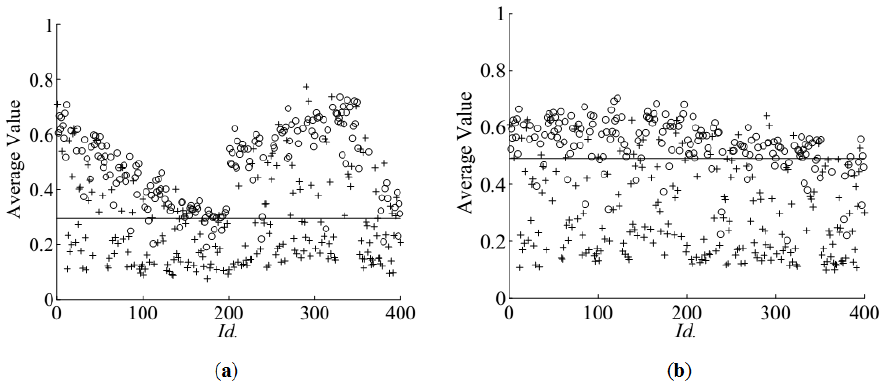
Figure 3. Reference germination data (experimental results) overlaid on Fav V (average value component in HSV-space images captured by machine vision camera): ( a ) average value of non-normalized images of cross-sections; ( b ) average value of normalized images of cross-sections. Legend: ‘o’ germinating, ‘+’ non-germinating, ‘−’ level of separation threshold rendering maximum accuracy.